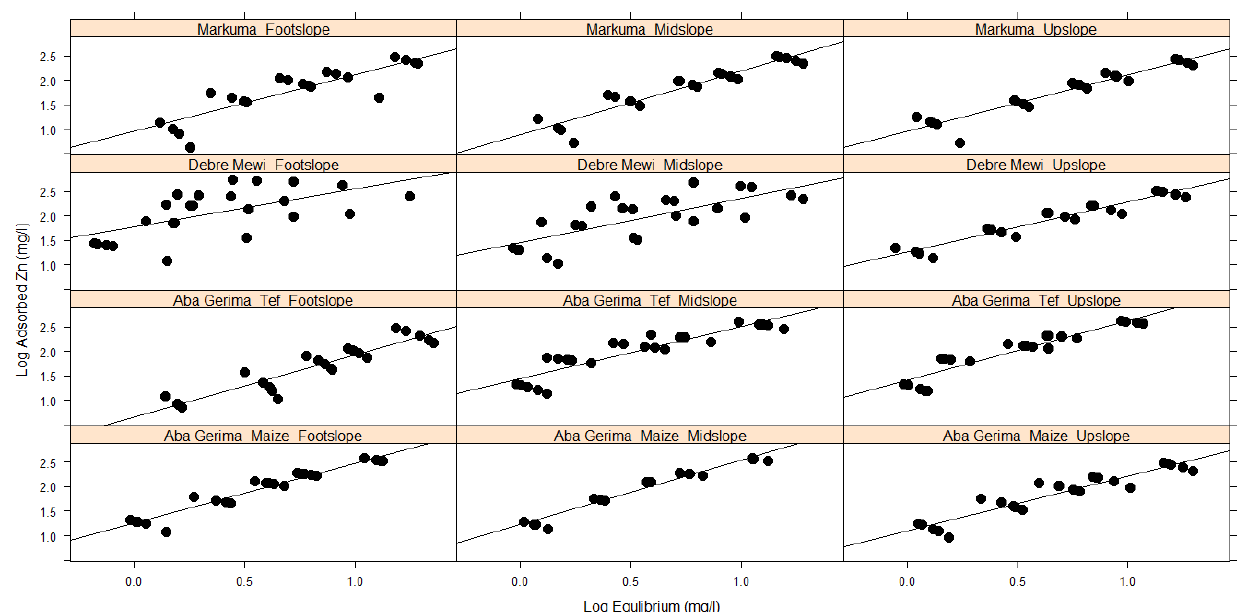
Figure 4. Adsorption data fitted to the Freundlich isotherm.